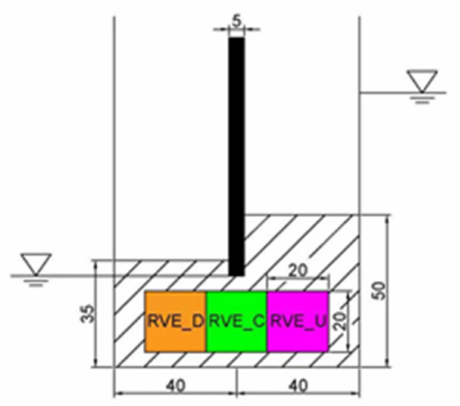
Figure 1. Initial configuration of the